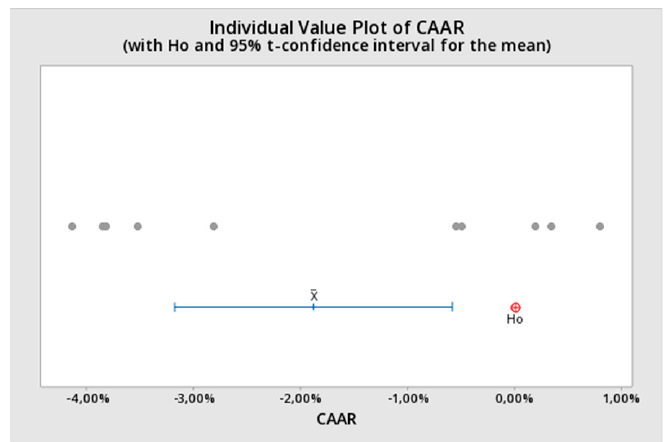
Figure 7. t -Test P-P plot of CAAR for E ( − 5,+5) .